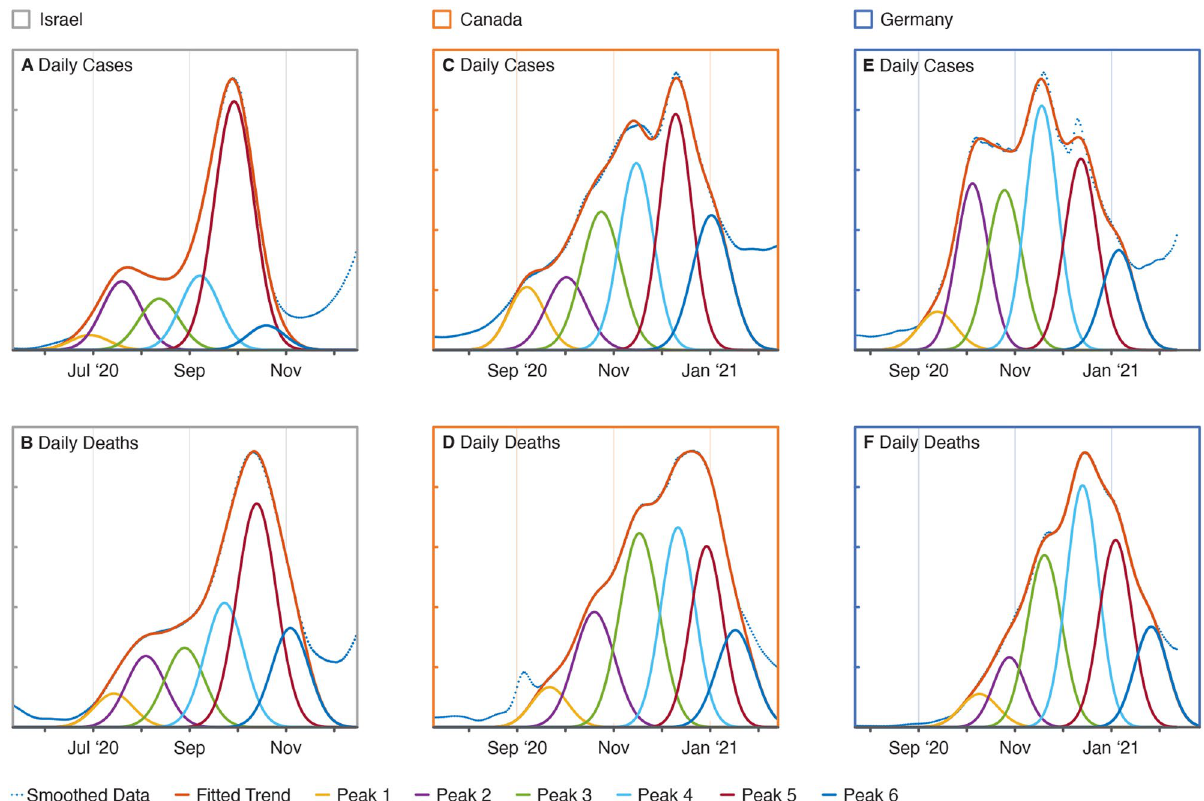
Figure 2. Peak fits for national daily cases and deaths reported from the second wave of the COVID-19 pandemic: ( A ) Israel daily cases, ( B ) Israel daily deaths, ( C ) Canada daily cases, ( D ) Canada daily deaths, ( E ) Germany daily cases, and ( F ) Germany daily